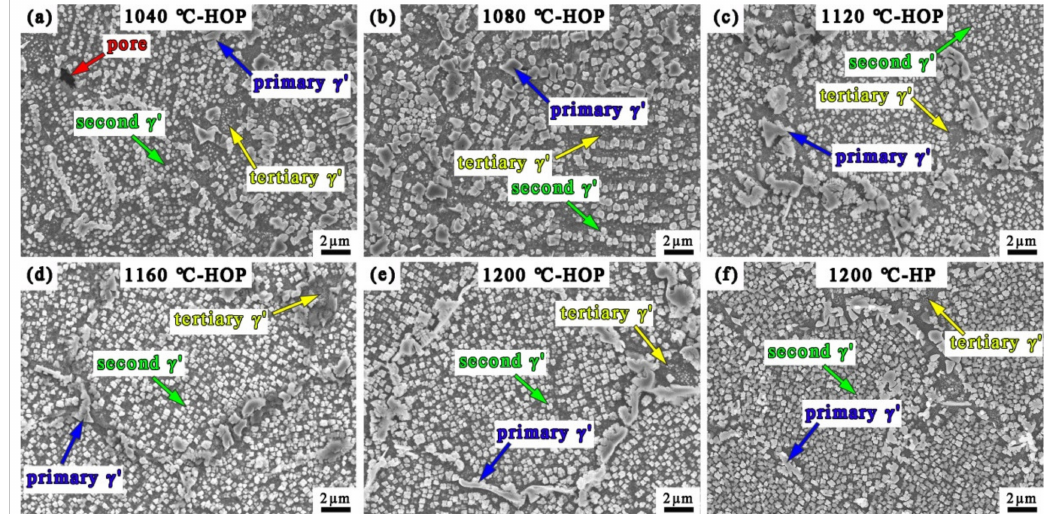
Figure 7. The morphology of the γ (cid:48) phases of the HOPed and HPed samples: ( a ) 1040 ◦ C-HOP; ( b ) 1080 ◦ C-HOP; ( c ) 1120 ◦ C-HOP; ( d ) 1160 ◦ C-HOP; ( e ) 1200 ◦ C-HOP; ( f ) 1200 ◦ C-HP.